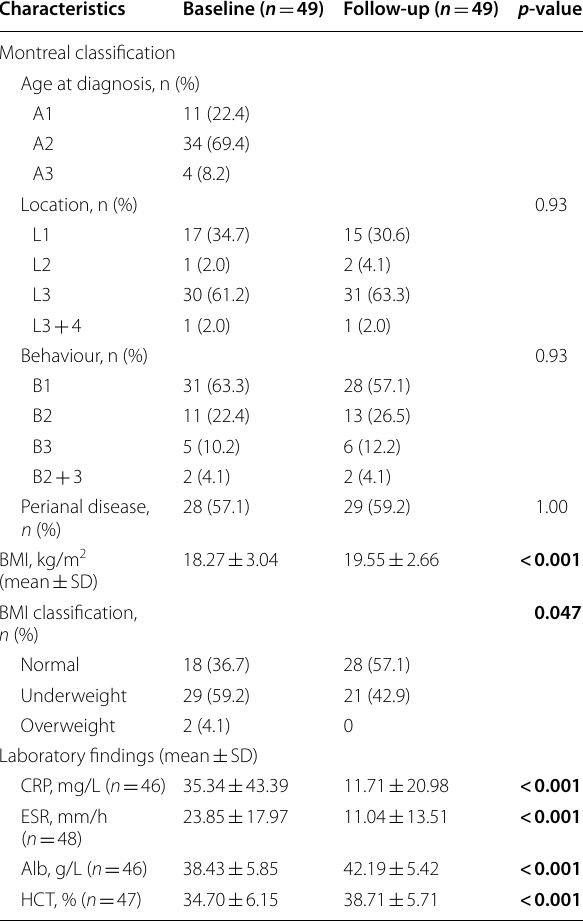
Table 1 Clinical features of all Crohn’s disease patients Characteristics